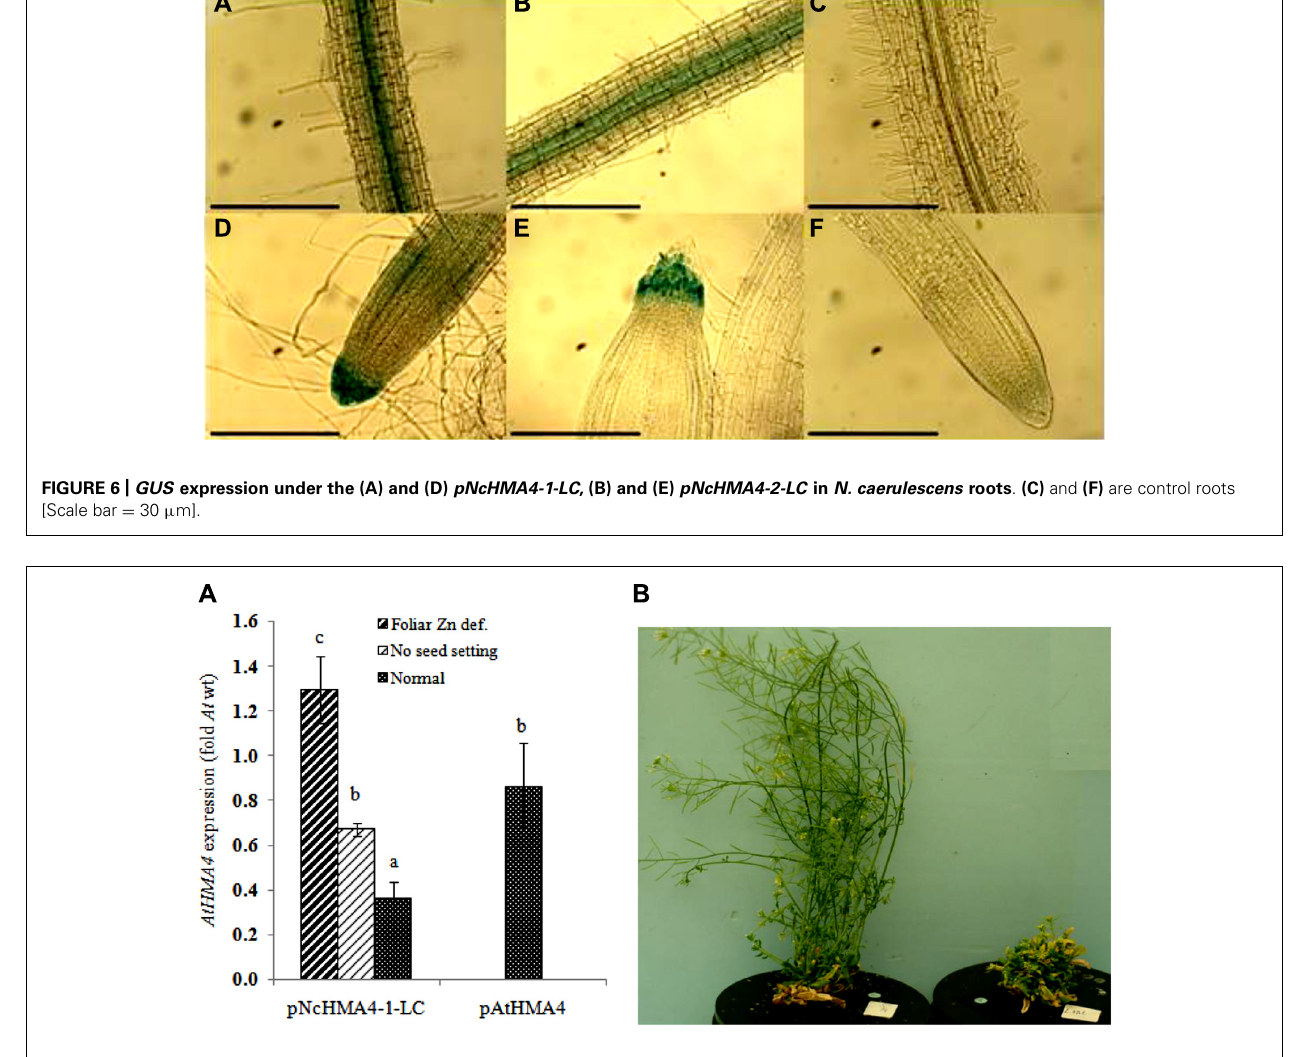
FIGURE 7 | (A) HMA4 expression in the root of transgenic Arabidopsis hma2hma4 double mutant plants (fold expression relative to At wild-type). (B) Arabidopsis hma2hma4 double mutant transformed by pNcHMA4-1-LC::AtHMA4 , on the left a plant expressing AtHMA4 at a low level and on the right one with high AtHMA4